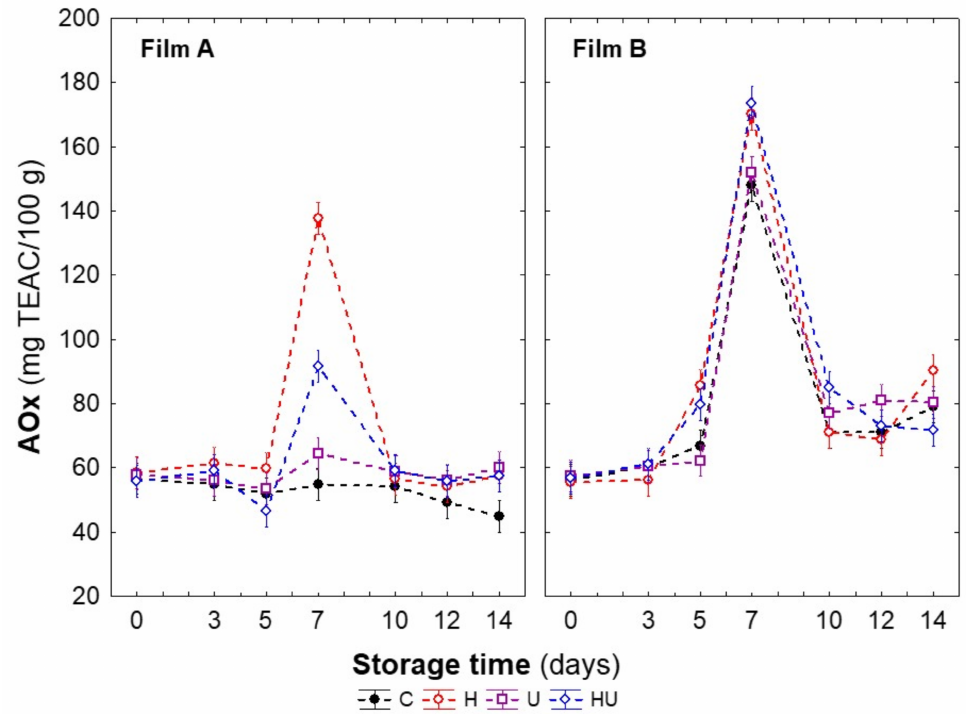
Figure 4. Changes in antioxidant capacity of fresh-cut carrots as affected by abiotic stress treatments and MAP conditions during low-temperature storage (5 ◦ C, 14 days). Vertical bars denote the confidence interval at